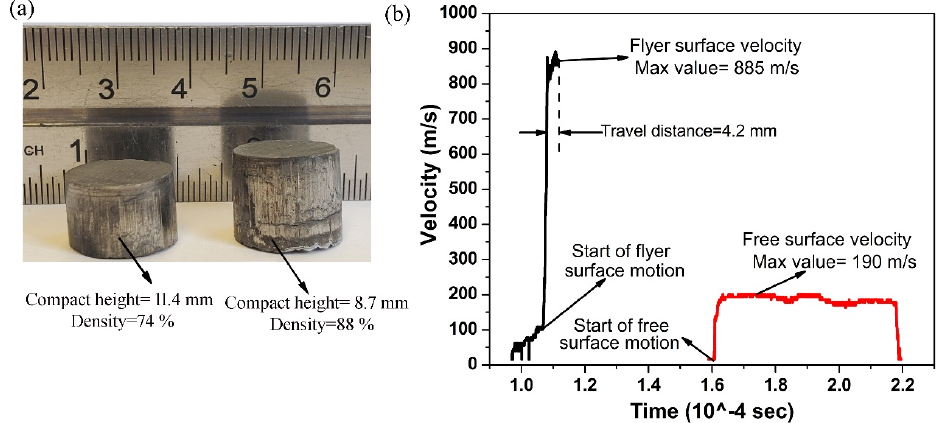
Table 1. Experimental setup parameters and the result obtained using different projectile configurations.